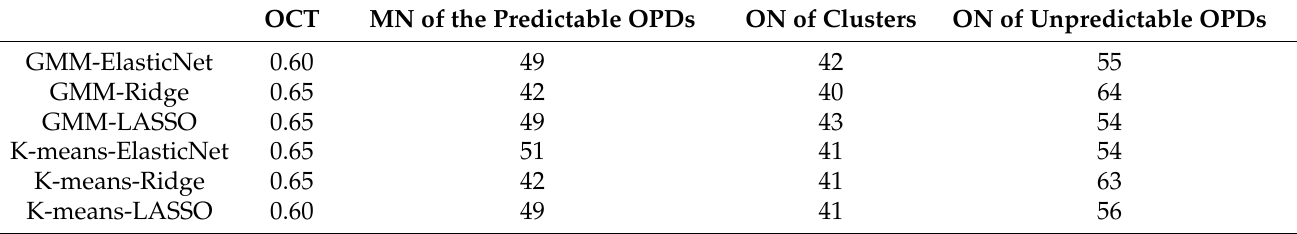
Table 2. The results of the six combinational models under the predicting metric threshold of 0.8. OCT is the abbreviation for optimal CT. OPD is the abbreviation for odor perception descriptor. ON is the abbreviation for optimal number. MN is the abbreviation for maximum